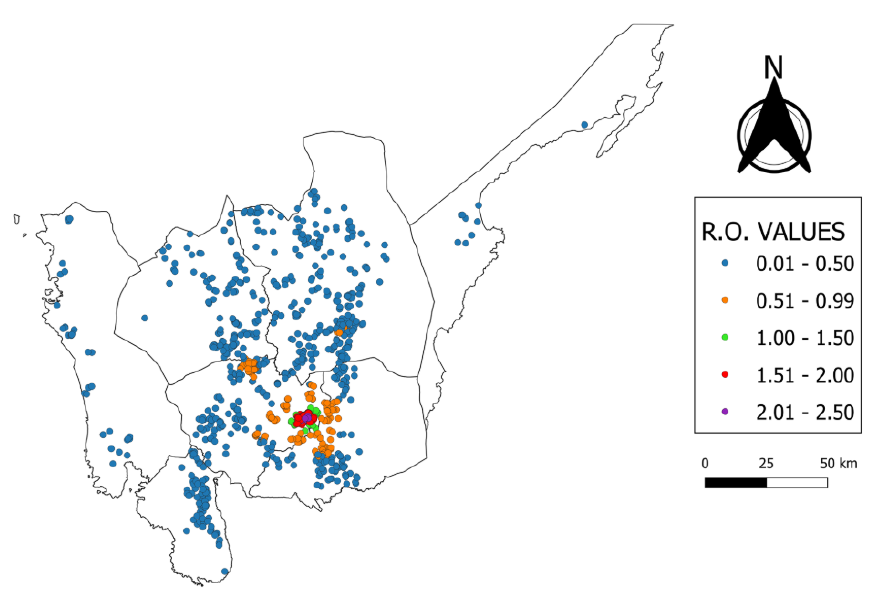
Figure 3. Risk map of highly pathogenic avian influenza transmission in Central Luzon, Philippines.